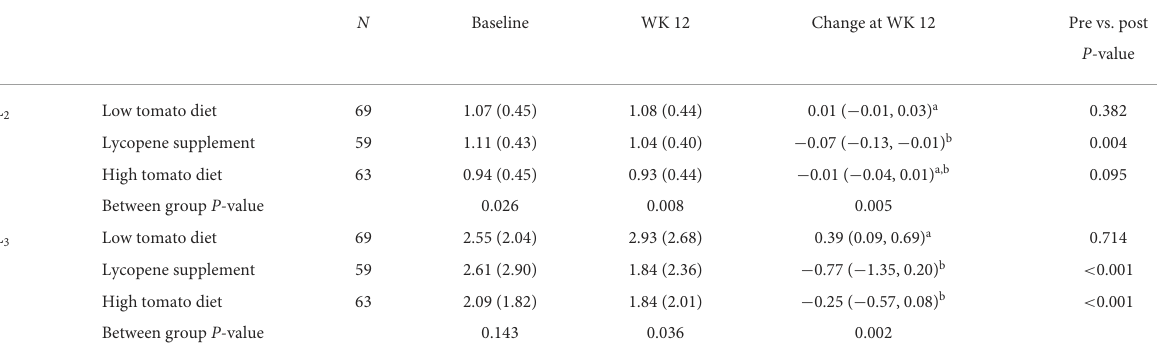
TABLE 6 CETP activity in HDL 2 and HDL 3 following 12-week intervention with either a low tomato diet, lycopene supplement, or high tomato diet.